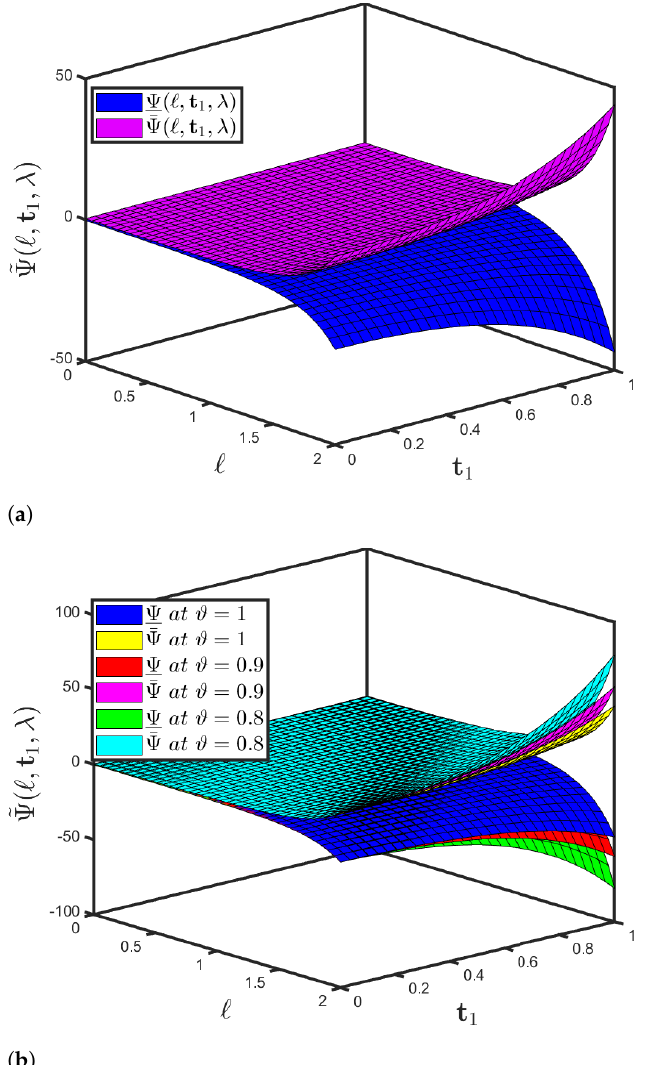
Figure 13. Three-dimensional plot of ˜ Ψ ( (cid:96) , t 1 ; λ ) of Problem (4): ( a ) Ψ ( (cid:96) , t 1 ; λ ) and ¯ Ψ ( (cid:96) , t 1 ; λ ) when ϑ = 1; ( b ) Ψ ( (cid:96) , t 1 ; λ ) and ¯ Ψ ( (cid:96) , t 1 ; λ ) when the uncertainty parameter λ ∈ [ 0,1 ] has different fractional or-